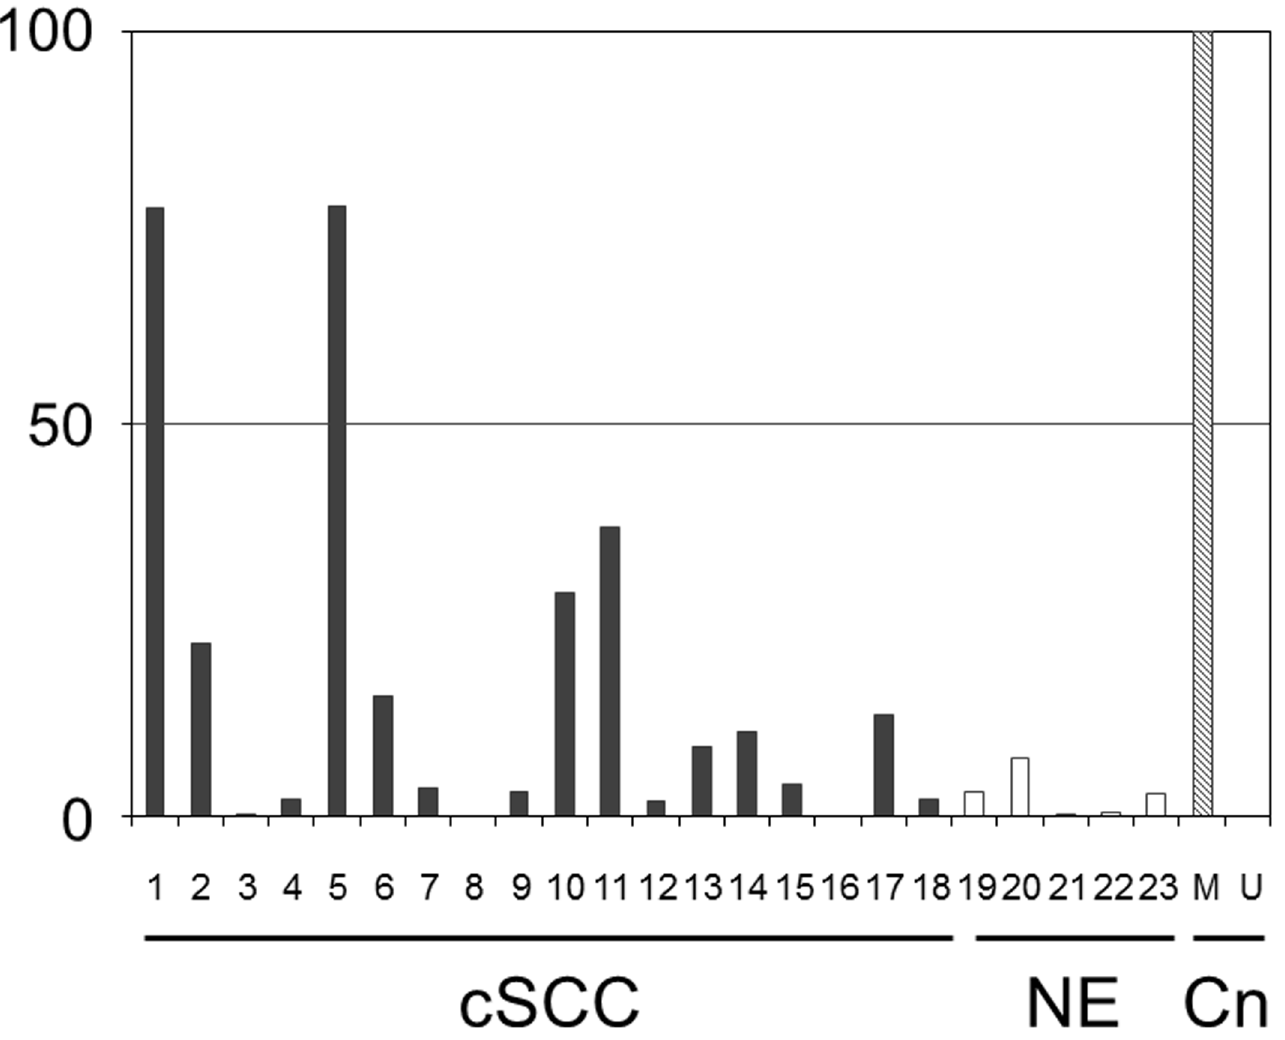
Fig 3. The methylation levels of the CGI located in the 5’ region of G0S2 in 17 clinical cutaneous SCC samples (cSCC, #1 to #17) and six normal epidermis samples (NE, #19 to #23). The vertical and horizontal rows of numbers indicatethe methylationlevel (%) and each sample ID, respectively. M and U indicate the experimental controls (Cn) of methylatedcontrol DNA and unmethylated control DNA,